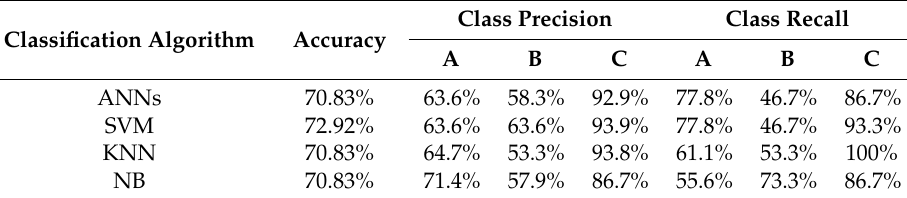
Table 4. Results of classification with integrated data.